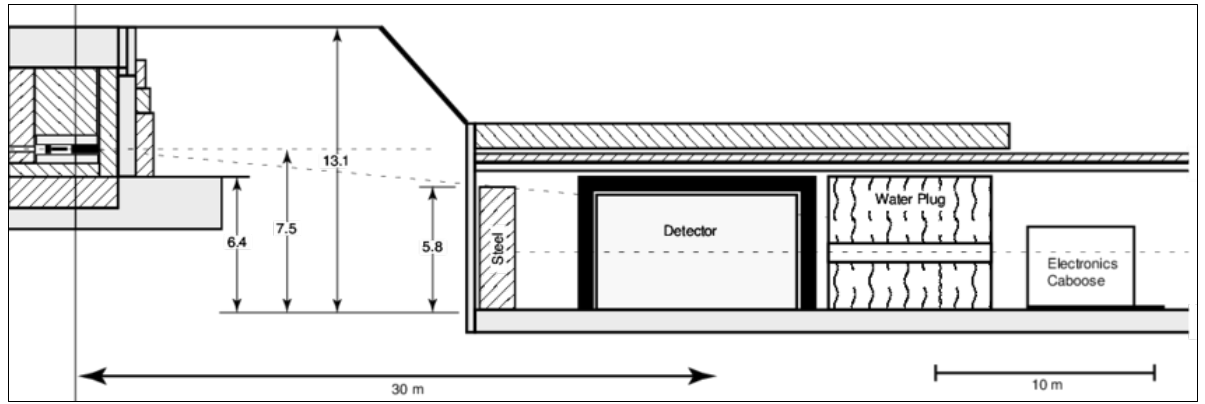
Figure 4. Detector enclosure and target area configuration, elevation